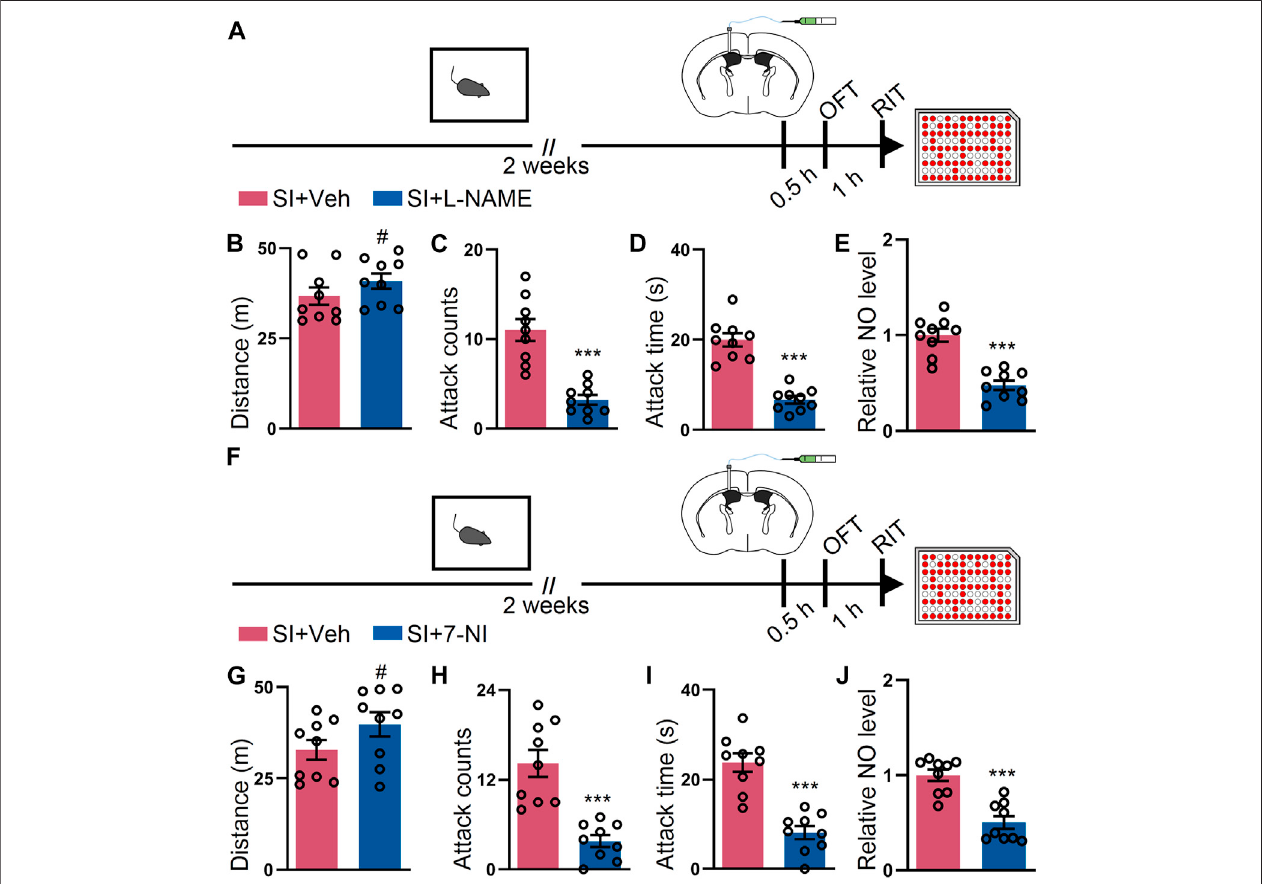
FIGURE 3 | L-NAME or 7-NI blocked SI-induced heightened attack behavior. (A) An outline of the experimental procedure for behavioral tests and NO detection. The mice were implanted with a guide cannula and singly housed for 2 weeks. Afterward, L-NAME was injected via the ICV route, and behavioral tests were performed. (B) Total distanceofmicetreatedasshown in (A) during theOFT (t 16 (cid:1) 1.279, p (cid:1) 0.2193). (C) Attack counts ofmice treatedasshown in (A) during theRIT(t 16 (cid:1) 5.798, p < 0.001). (D) Total attack time of mice treated as shown in (A) during the RIT (t 16 (cid:1) 7.798, p < 0.001). (E) The relative NO level of the cortex from mice treated as shown in (A) (t 16 (cid:1) 6.309, p < 0.001). (F) An outline of the experimental procedure for behavioral tests and NO detection. The mice were implanted with a guide cannula and singly housed for 2 weeks. Afterward, 7-NI was injected via the ICV route, and behavioral tests were performed. (G) Total distance of mice treated as shown in (F) duringtheOFT(t 16 (cid:1) 1.629, p (cid:1) 0.1229). (H) Attackcountsofmicetreatedasshownin (F) duringtheRIT(t 16 (cid:1) 5.267, p < 0.001). (I) Totalattack timeofthemicetreated as shown in (F) during the RIT (t 16 (cid:1) 6.187, p < 0.001). (J) The relative NO level of the cortex from mice treated as shown in (F) (t 16 (cid:1) 5.489, p < 0.001). Data